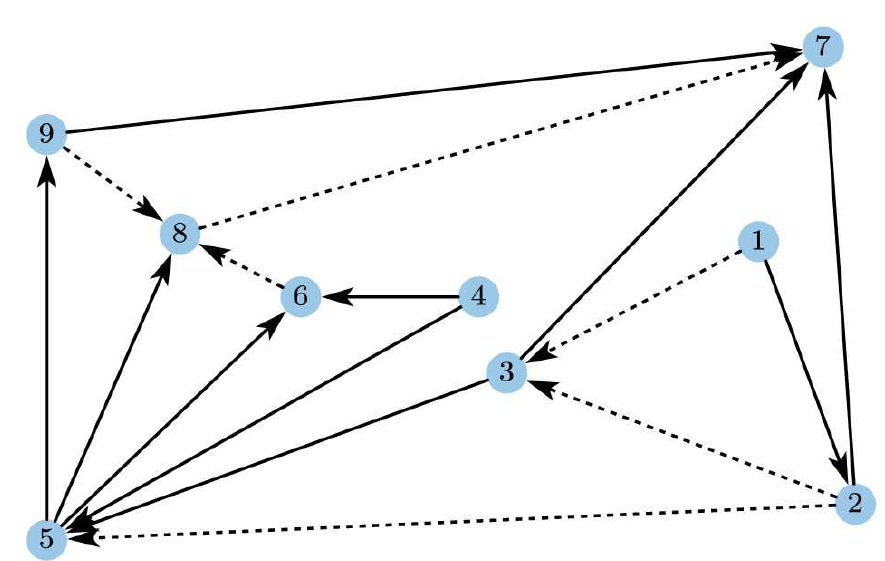
Figure 9. Another topological structure of the nine agents in Example